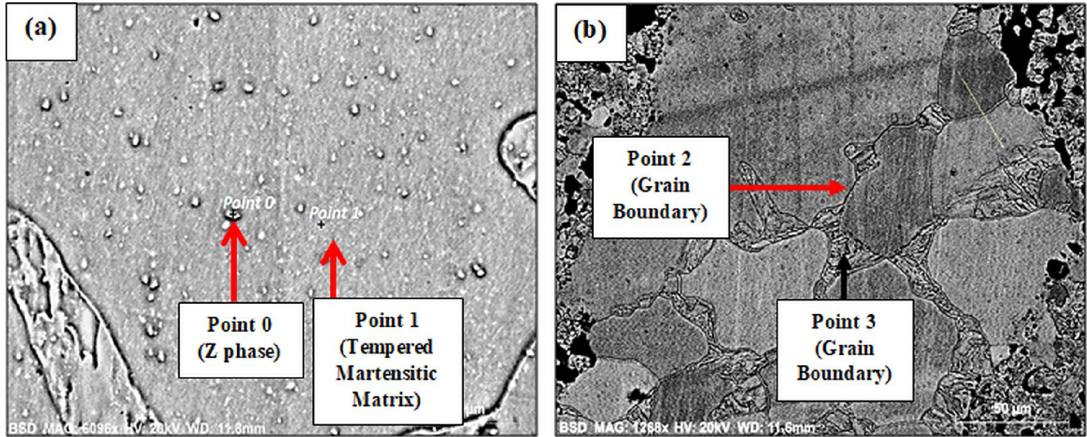
Figure 4. X22CrMoV12-1 alloy spots of chemical analysis (a) View of matrix and precipitates (b) View of grain boundaries.